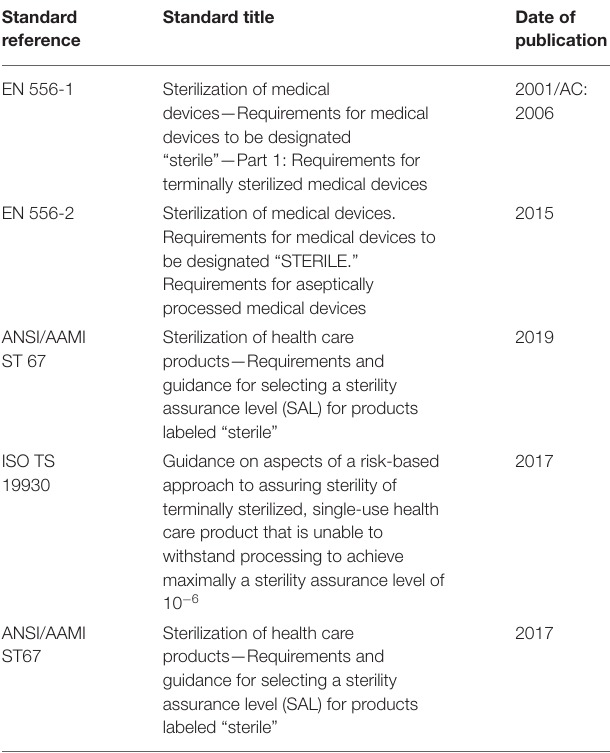
TABLE 7 | Standards related to designating medical devices as